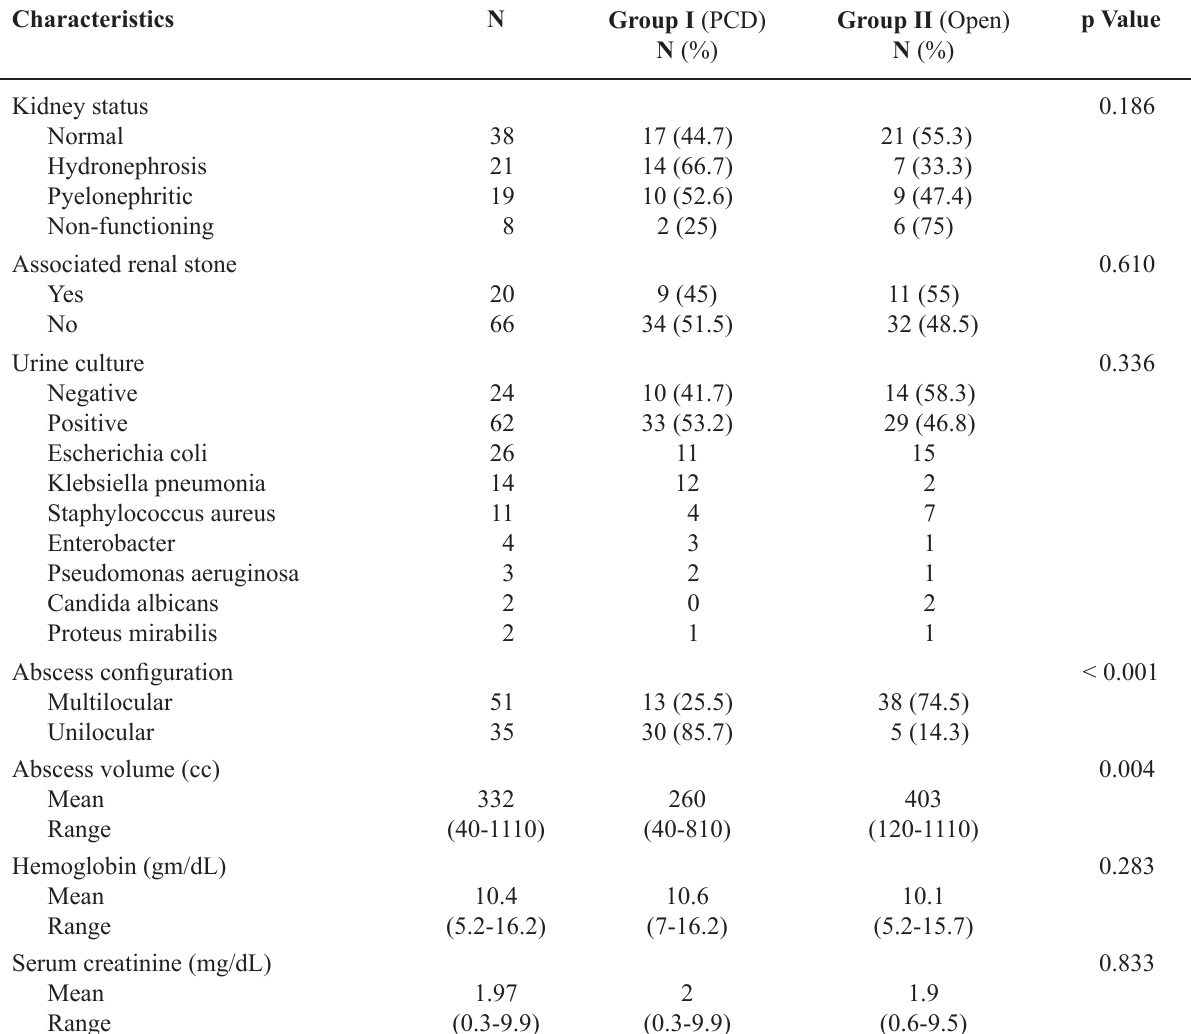
Table 2 – Preoperative radiological and laboratory data of 86 patients with perinephric abscess.